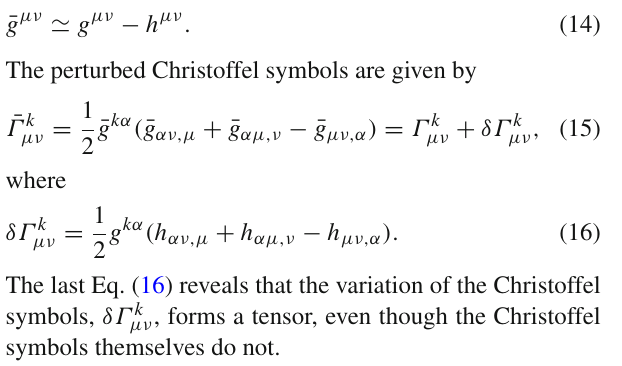
Fig. 1 Black hole’s effective